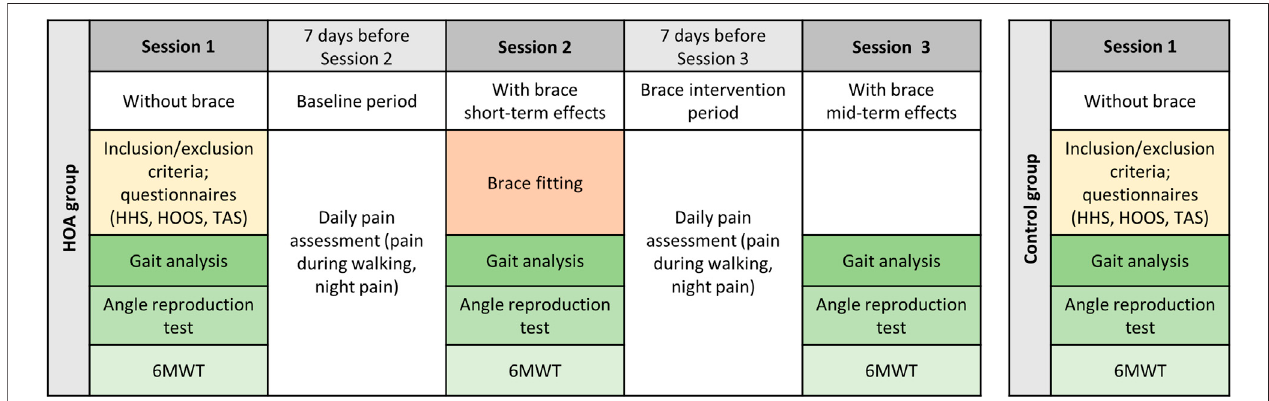
FIGURE 1 | Study procedure for the HOA and control groups. HHS = Harris Hip Score, HOOS = Hip Osteoarthritis Outcome Score, TAS = Tegner Activity Score, 6MWT = 6-minute walking test.